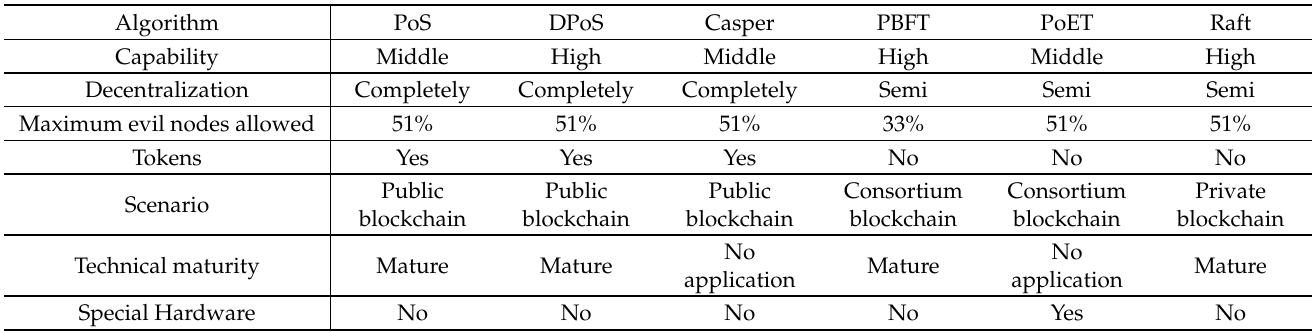
Table 2. Comparison of Consensus